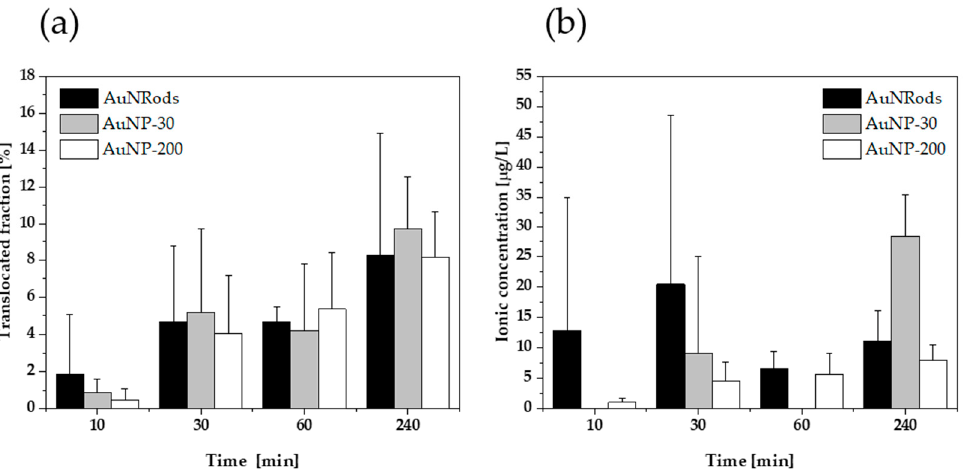
Figure 4. Gastrointestinal translocation of AuNRods and AuNPs determined by spICP-MS. ( a ) Relative particulate basolateral concentrations of the investigated AuRods and AuNPs in dependence of time. ( b ) Basolateral ionic concentration in dependence of time. n = 3.